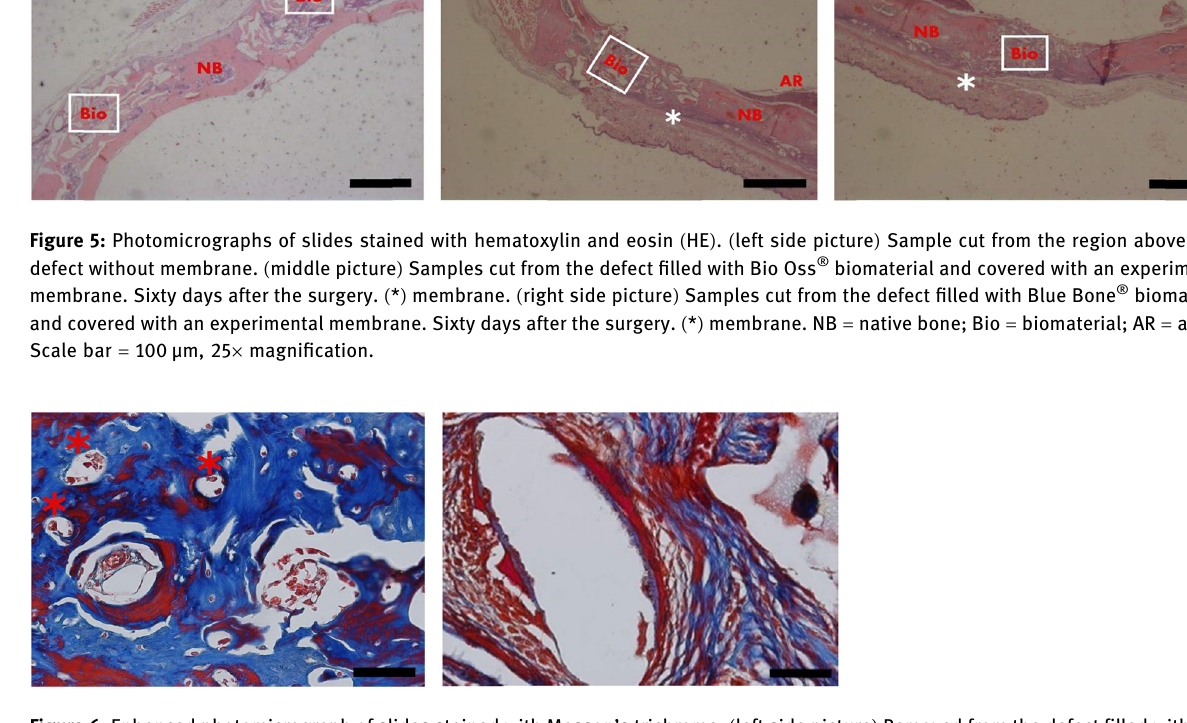
Figure 6: Enhanced photomicrograph of slides stained with Masson ’ s trichrome. ( left side picture ) Removed from the defect fi lled with Blue Bone ® biomaterial and covered with the membrane. Many blood vessels can be observed. ( right side picture ) Removed from the defect fi lled with Bio Oss ® biomaterial and covered with the membrane. Sixty days after surgery. Blue shows the mineralized new bone. Scale bar = 100 µm, 40 × magni fi cation.